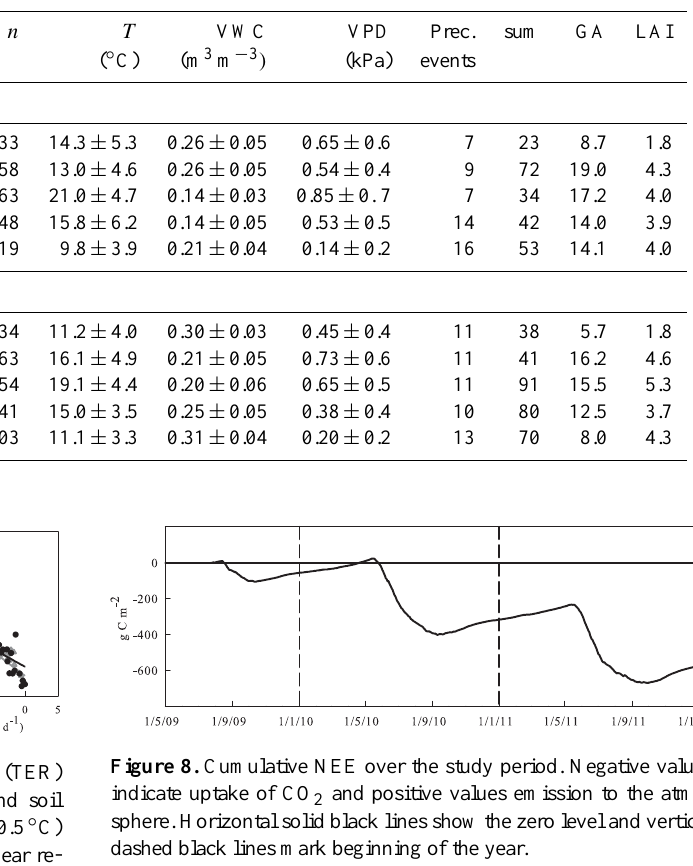
Table 1. Monthly fit results of a rectangular hyperbolic model together with average climatic conditions – the fit results between gross primary production (GPP, µmolm − 2 s − 1 ) binned with photosynthetically active radiation (PAR, µmolm − 2 s − 1 , bins from 0 to 1800µmolm − 2 s − 1 with an interval of 10µmolm − 2 s − 1 ) from mid-May to September in 2010 and 2011. A rectangular hyperbolic model of the form GPP = (GP max × PAR × α /(GP max + PAR × α) , where GP max ( ± SE, µmolm − 2 s − 1 ) is the theoretical maximum rate of photosynthesis at infinite PAR and α ( ± SE) is the apparent quantum yield – i.e. the initial slope of the light response curve was used. Adjusted R 2 of regression and number of PAR bins ( n ) are shown. Also monthly average ( ± SD) of air temperature ( T , ◦ C), volumetric water content (VWC, m 3 m − 3 ) at 2.5cm depth and vapour pressure deficit (VPD, kPa) are shown together with number of rain event days (when precipitation>0.2mm) in month, precipitation sum (prec., mmmo − 1 ) and monthly averaged green area (GA, m 2 m − 2 ) and leaf area (LAI, m 2 m − 2 ) indices.